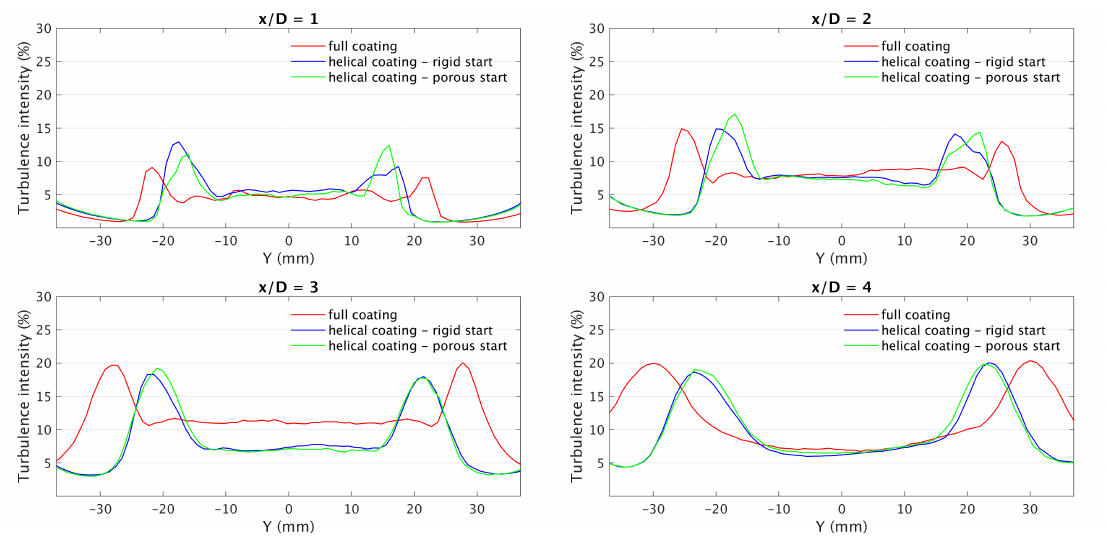
Figure 25. Turbulence intensity graph for cylinders 22 and 23.